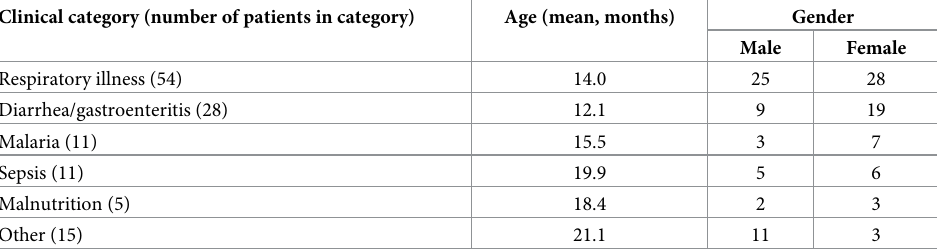
Table 1. Overview of the patients enrolled in the study. The other category includes: unknown (10), urinary infec- tion (1), meningitis (2), hepatitis (1), and fever (1). Information on gender was missing for three and on age for two